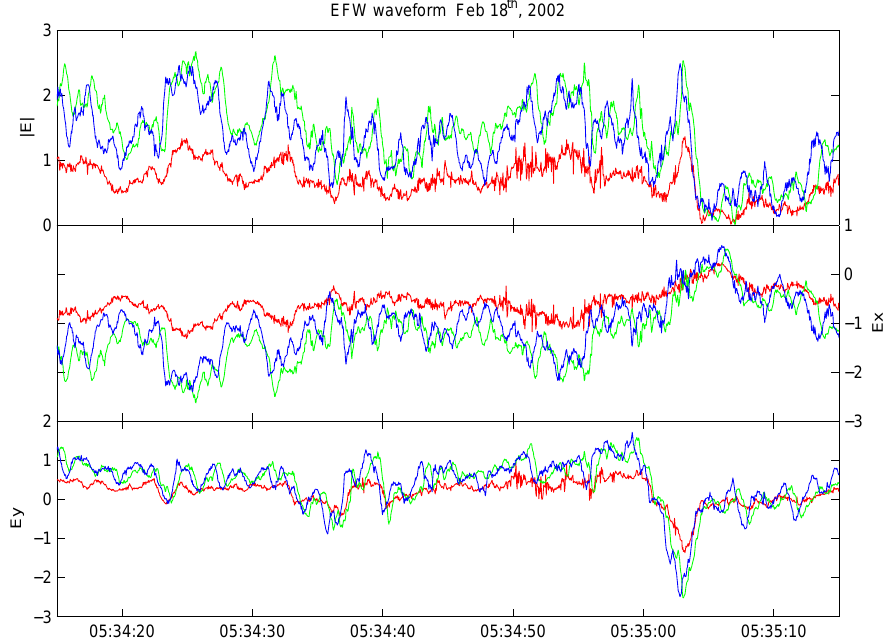
Fig. 2. The electric field measured by the EFW instruments. From top to bottom, the panels show the spin plane field magnitude, and the X and Y components. The coloured lines represent data from Cluster 2 (red), 3 (green), and 4 (blue). The X component seen on satellites 3 and 4 show strong evidence of fluctuations occurring at twice the spin frequency which is probably the result of one of the probe pairs passing through the wake of the satellites. Fig. 3. All three dispersions (using satellite